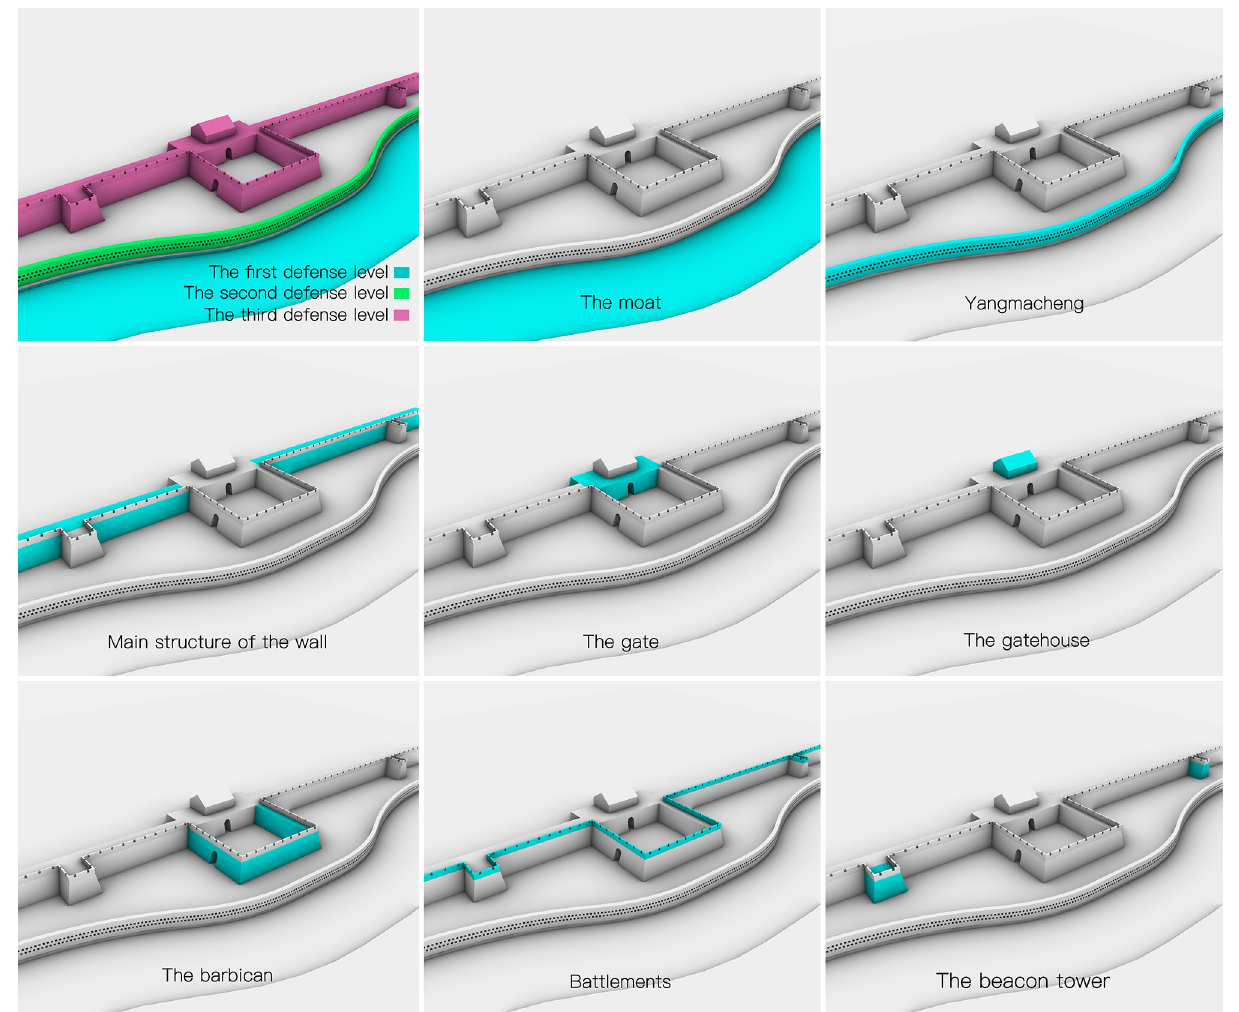
Fig 1. The structure of the three defense levels and the components of the third defense levels.